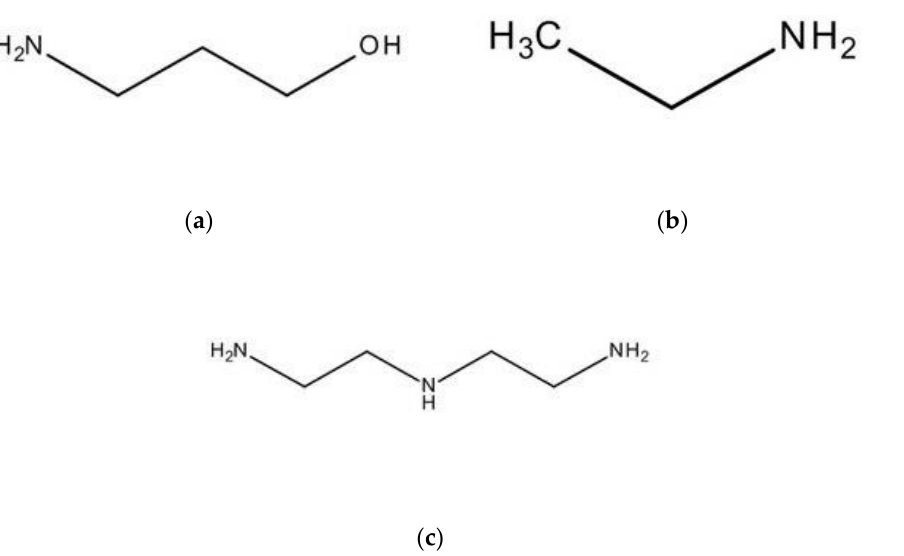
Figure 1. The chemical structure of ( a ) 3-Amino-1-propanol, ( b ) ethylamine, and ( c ) diethylenetri- amine.